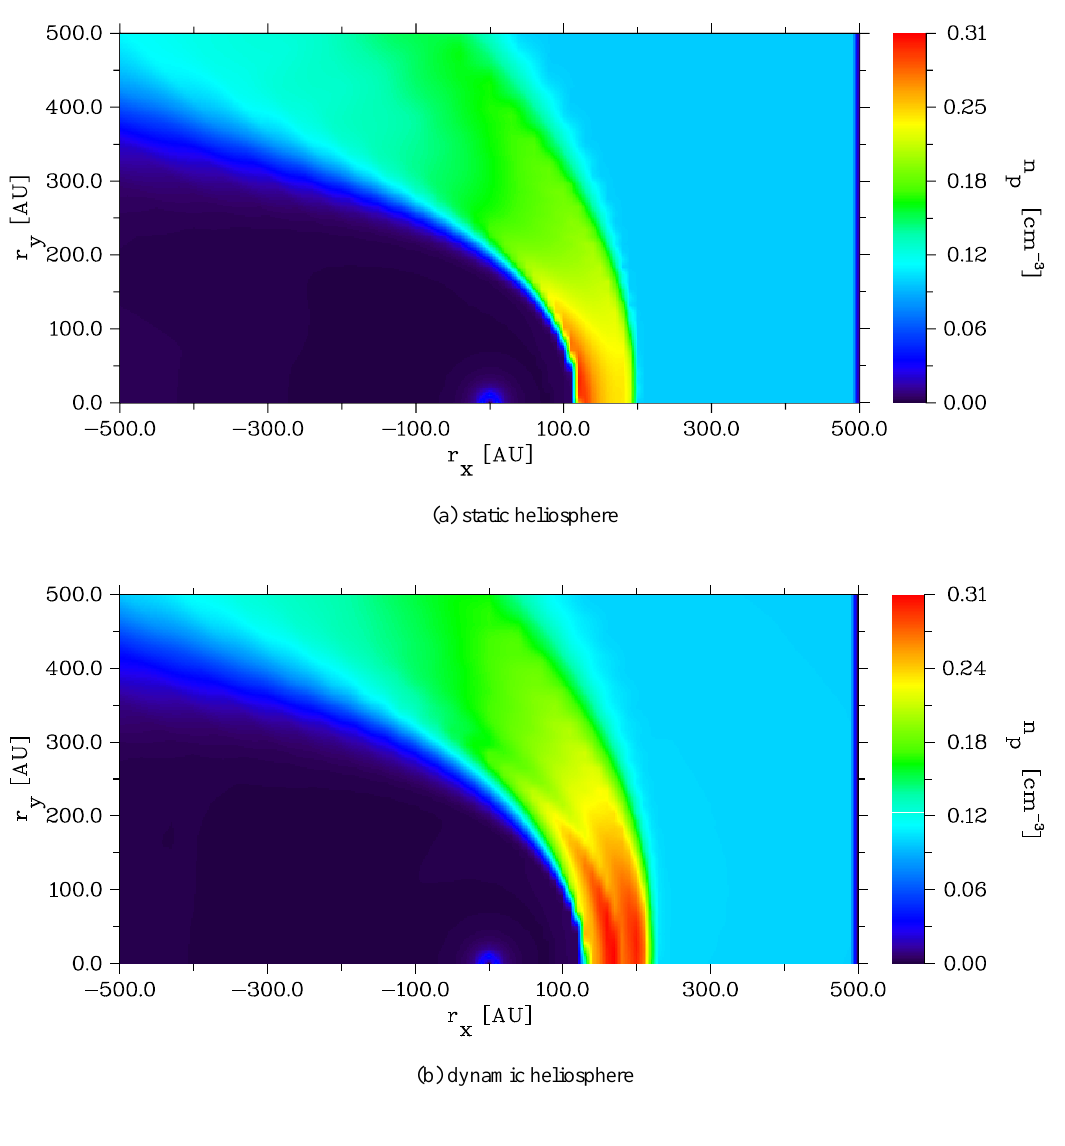
Fig. 1. The proton density variations for the static and the dynamic heliosphere (LISM flow from the right). In the upper panel the static model based on the parameters given in Table 1 is shown, while in the lower panel the dynamic heliosphere is presented, in which the solar wind speed and density at the inner boundary varies according to a sinusoidal law between 300km/s and 500km/s. For the varying distances of the termination shock and the bow shock see Fig.